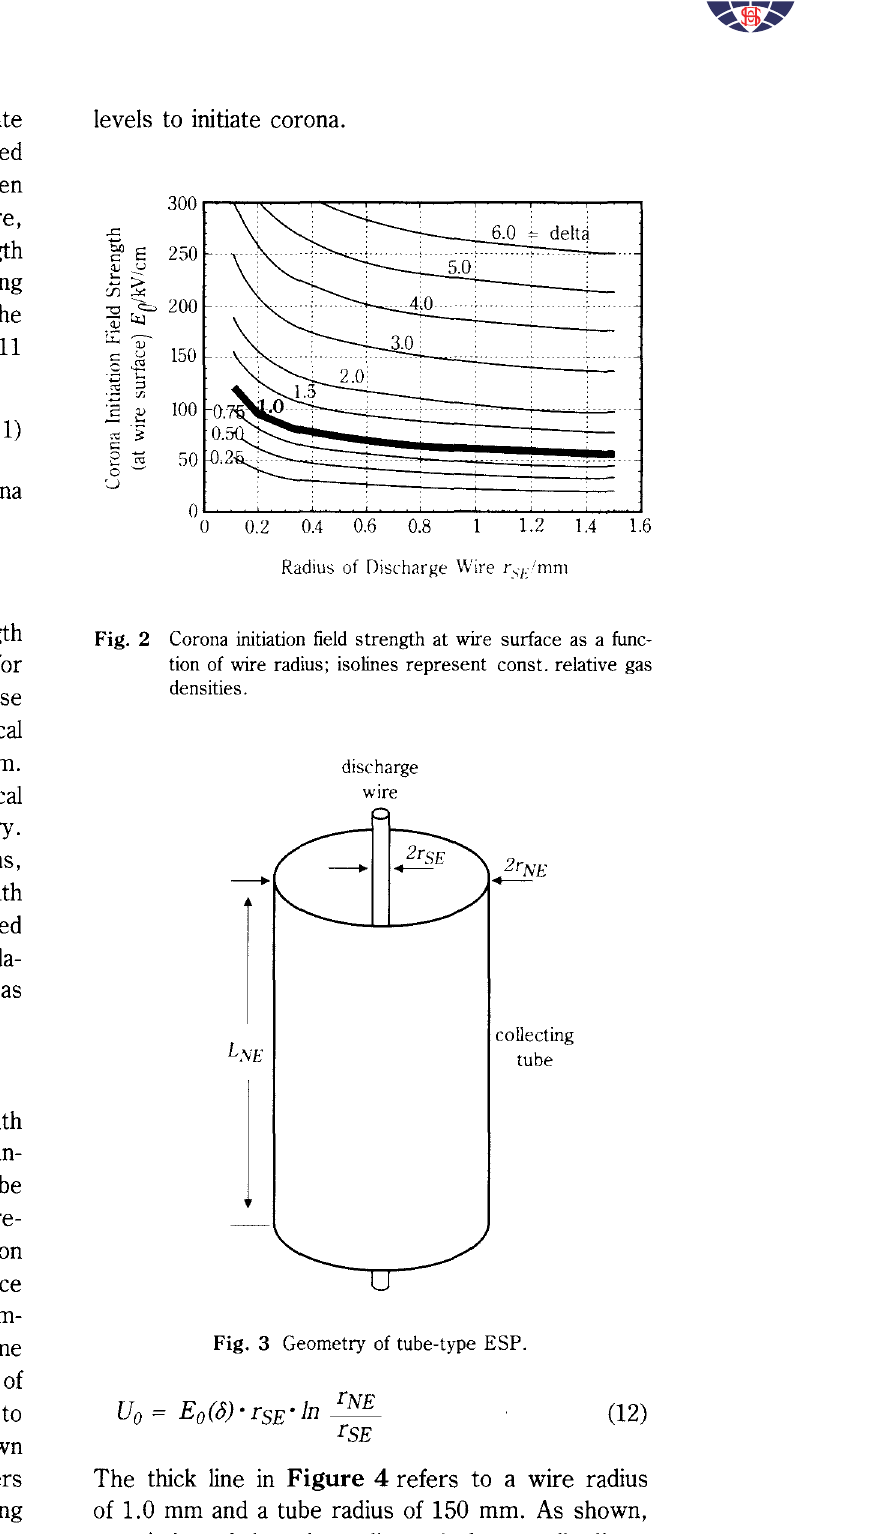
Fig. 2 Corona initiation field strength at wire surface as a func tion of wire radius; isolines represent const. relative gas densities.